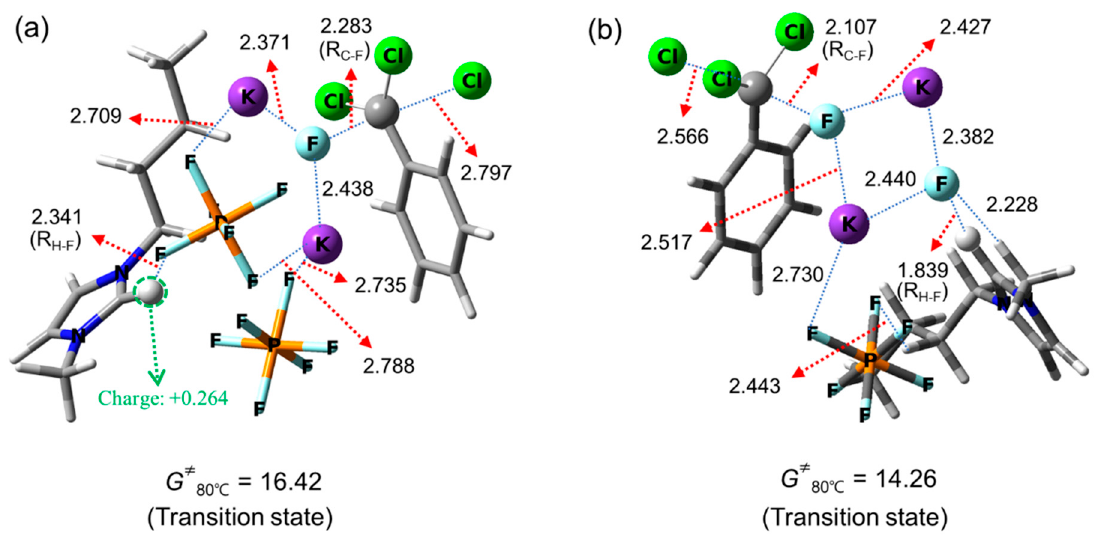
Figure 4. Calculated transition state of S N 2 fluorination in [bmim][PF 6 ] ( a ) activated by KPF 6 with